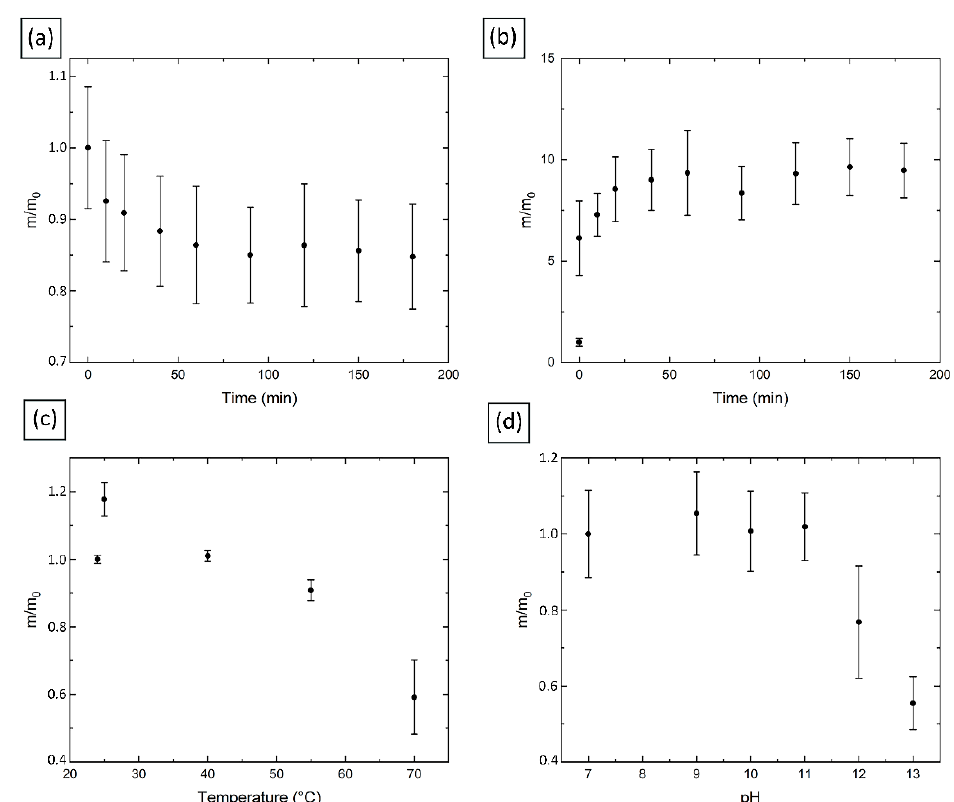
Figure 9. ( a ) Freshly prepared Cu/CS spherical gel sample swelling in water (high molecular weight chitosan, 0.116 M, 100 µL); ( b ) Freeze-dried Cu/CS spherical gel sample swelling in water; ( c ) Effect of temperature on the water swelling capacity of freshly prepared Cu/CS spherical gel sample; ( d ) Effect of pH on the water swelling capacity of freshly prepared Cu/CS spherical gel sample.